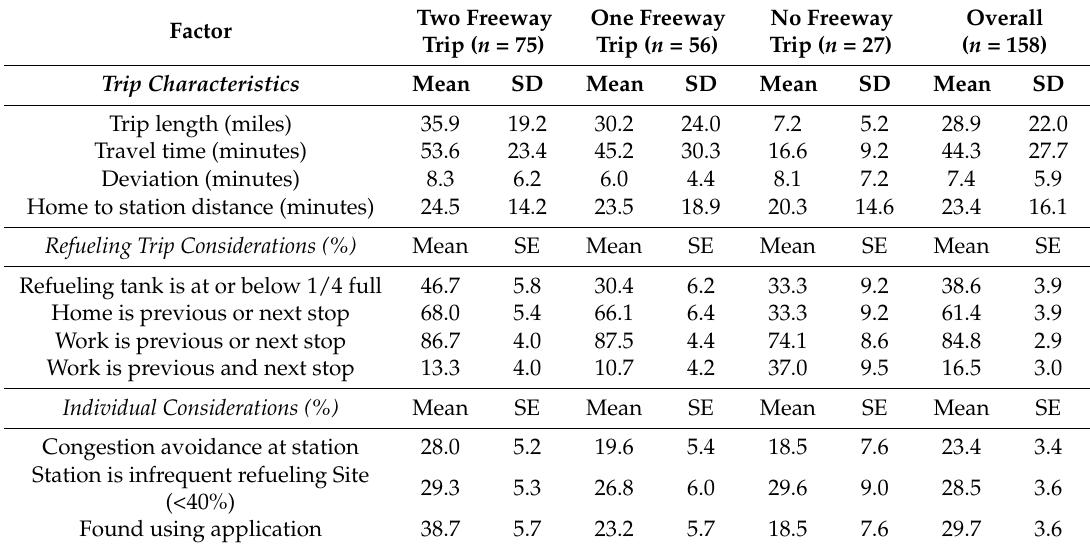
Table 1. Summary statistics of trip characteristics, by freeway refueling trip type